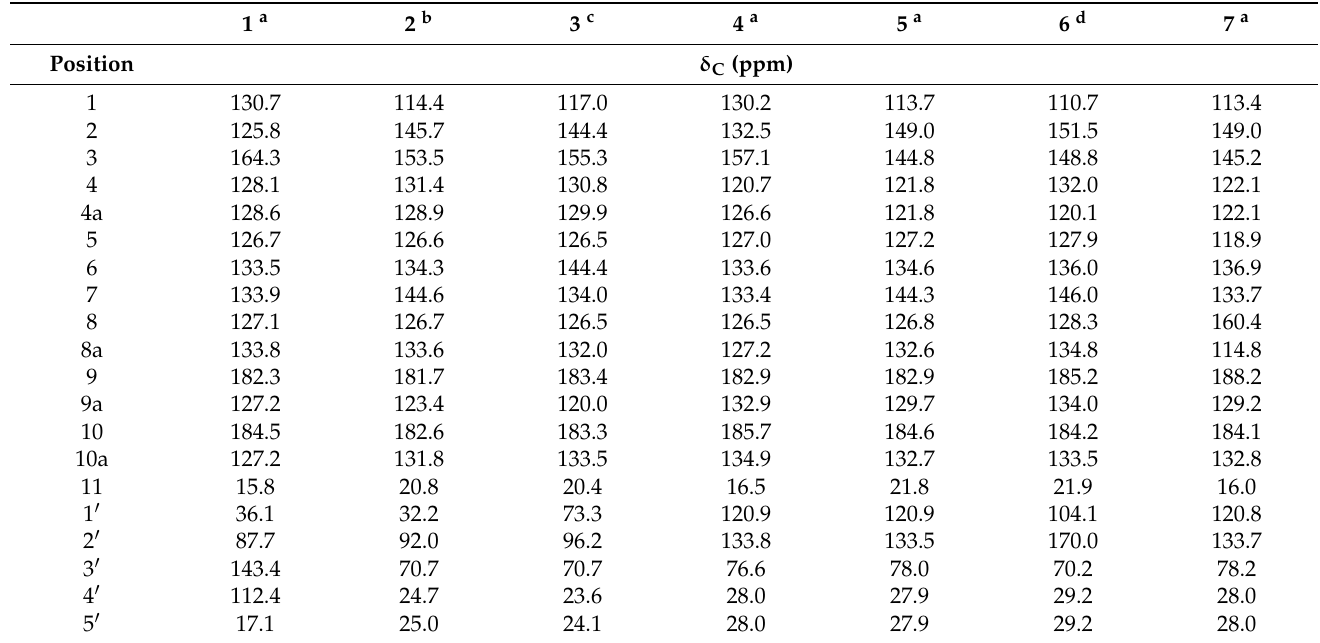
Table 2. The 13 C NMR spectral data of compounds 1 – 7